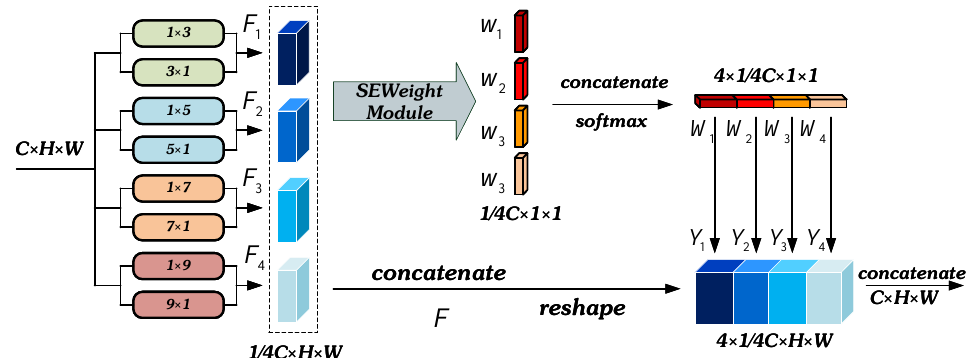
Figure 3. The structure of SPCA. C, H and W represent the number of channels, height and width of the